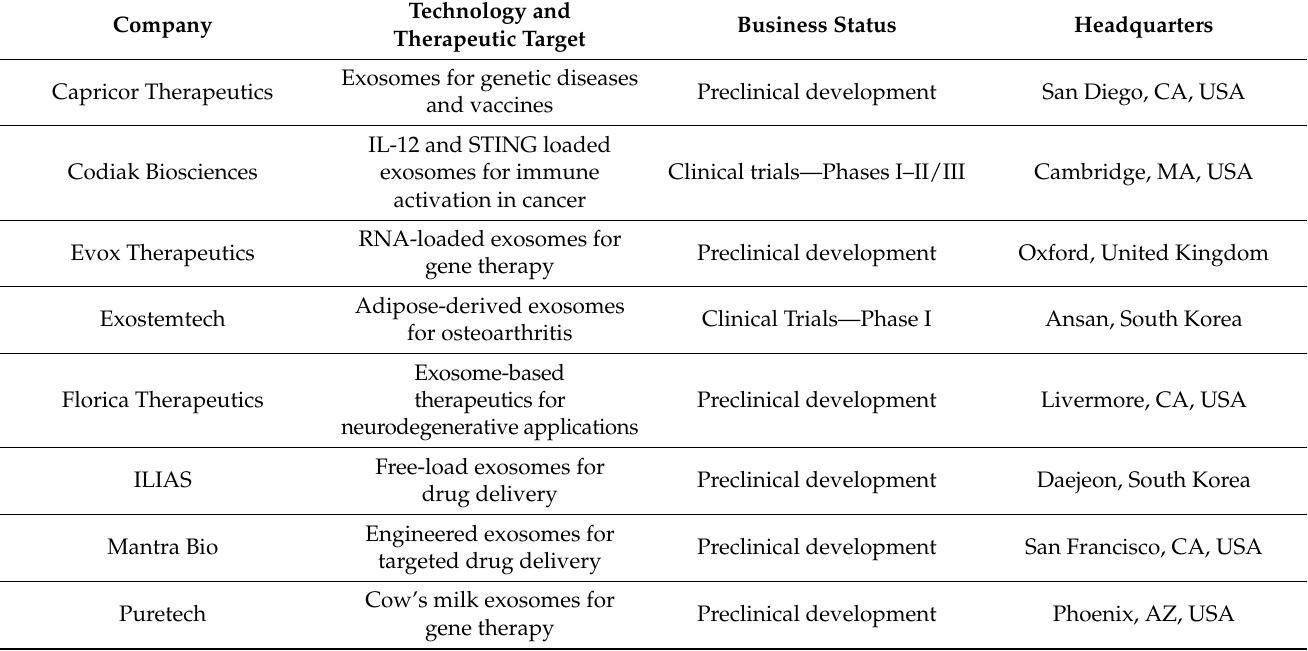
Table 1. Companies developing EV-based